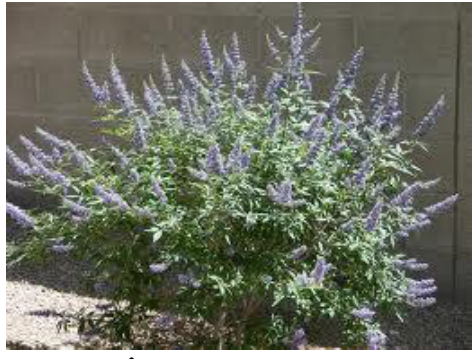
Figure 1: Vitex agnus-castus L.